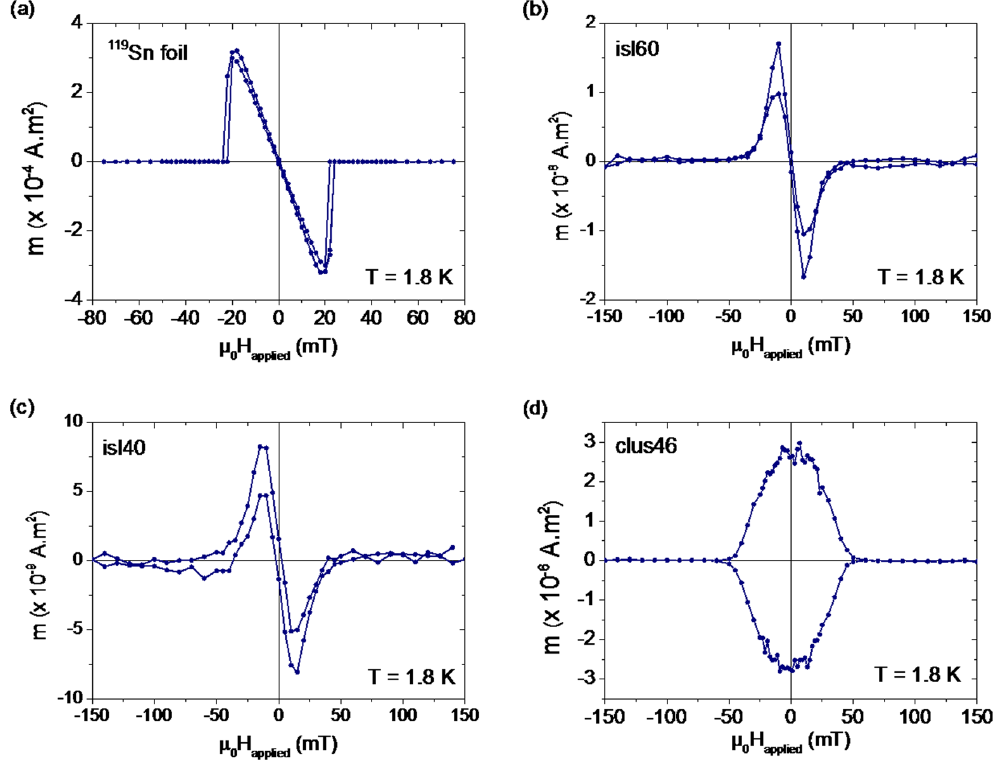
Figure 4. Magnetic moment ( m ) as a function of applied magnetic field at 1.8 K for the different Sn